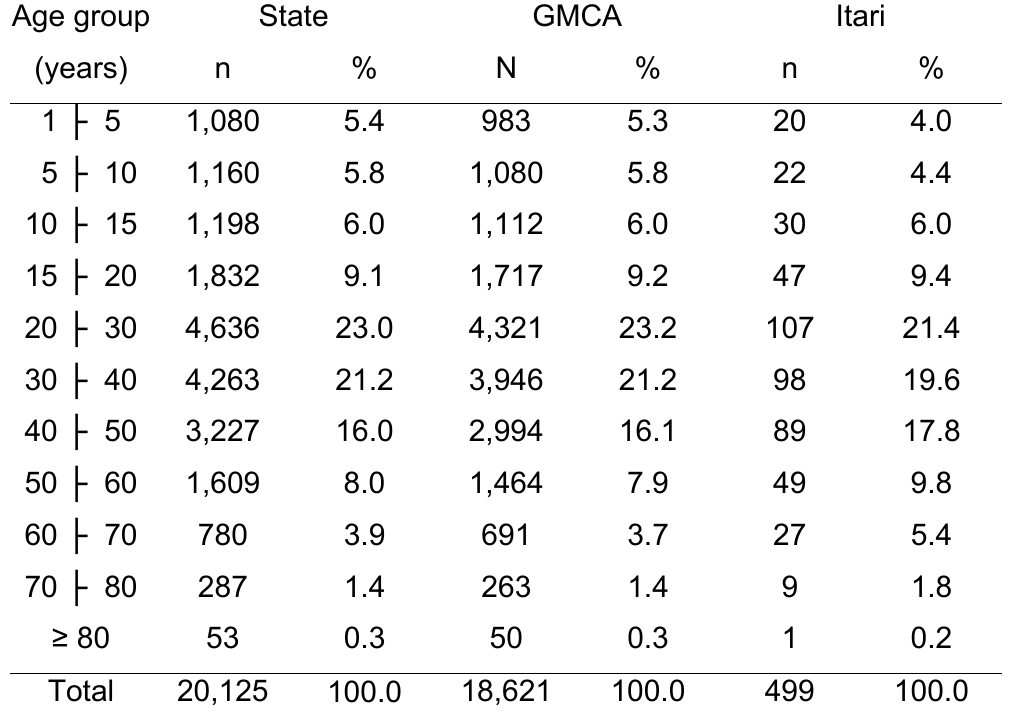
Table 1: Loxosceles spider bites by age group, Paraná State, Brazil, 1993-2000. Age group